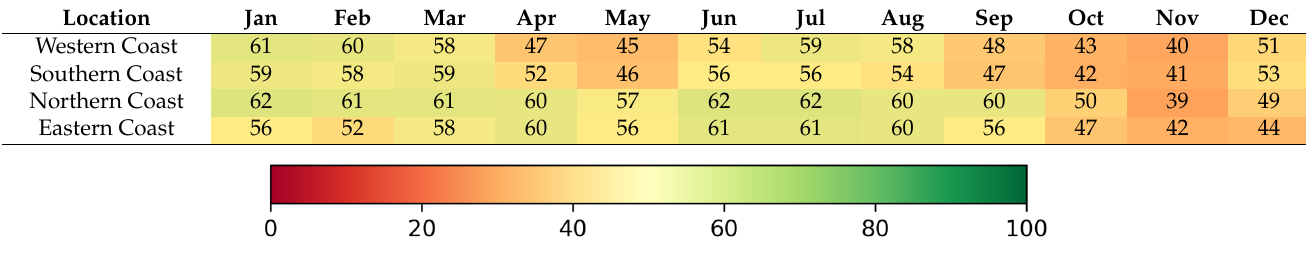
Table 1. HCI Beach values under measured climatic data (2010–2018).